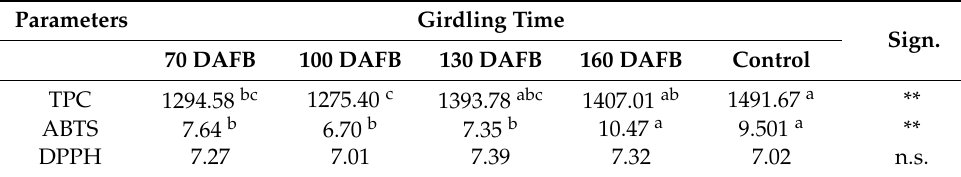
Table 7. Effects of girdling time on the total antioxidant capacity.